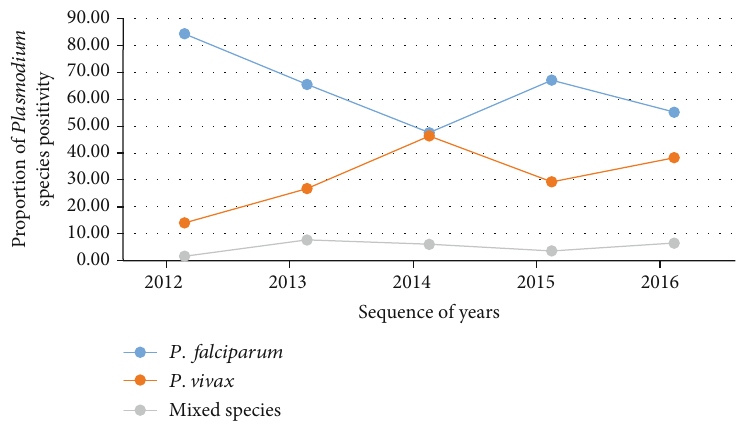
Figure 3: Trends of malaria species in at Dembecha Health Center, northwest Ethiopia (2011/12-2015/16).